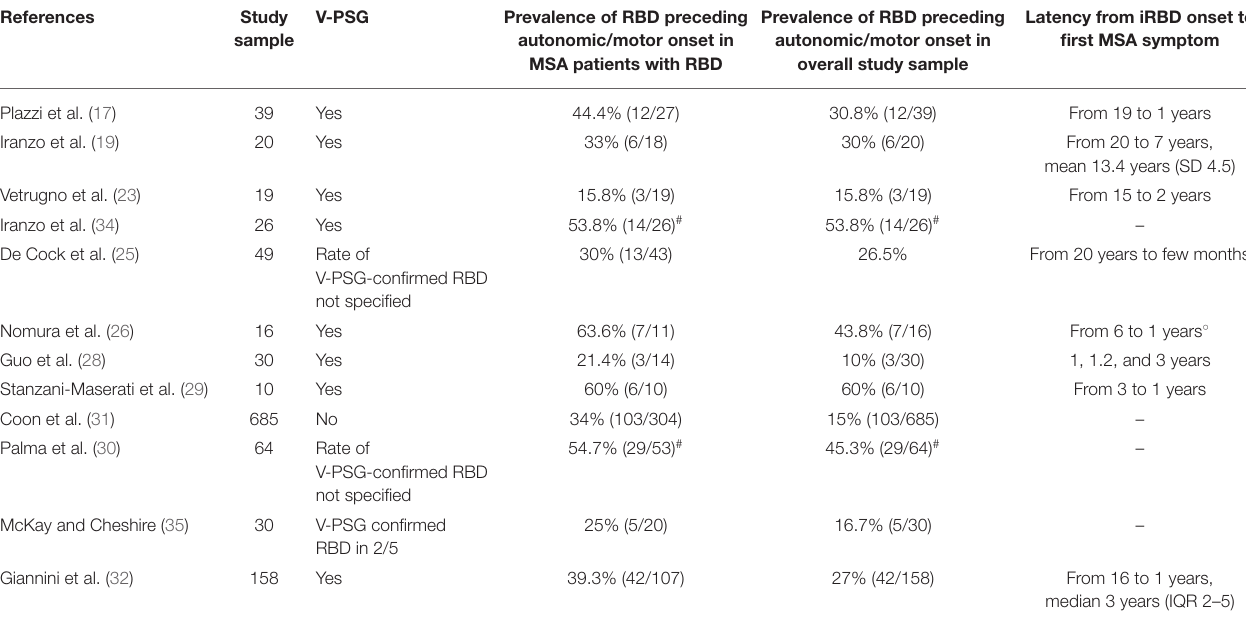
TABLE 2 | Studies reporting isolated RBD as initial manifestation of